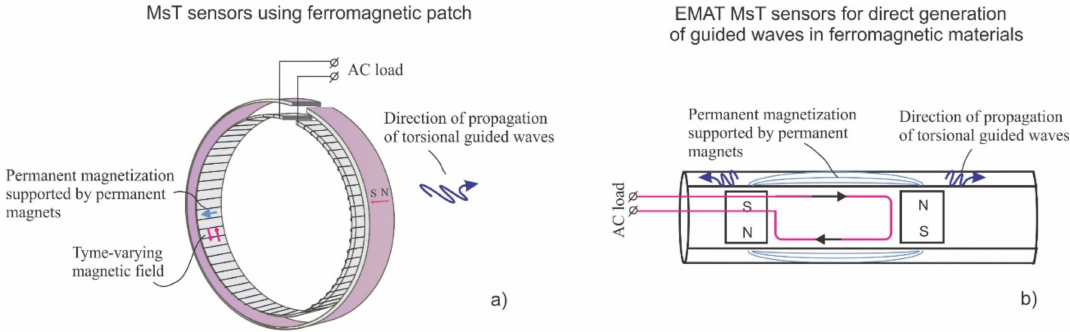
Figure 3. Sensors utilizing a reversed Wiedemann effect: ( a ) a magnetostrictive transducer (MsT) for the guided wave testing of pipes; ( b ) an EMAT MsT for the testing of heat exchanger